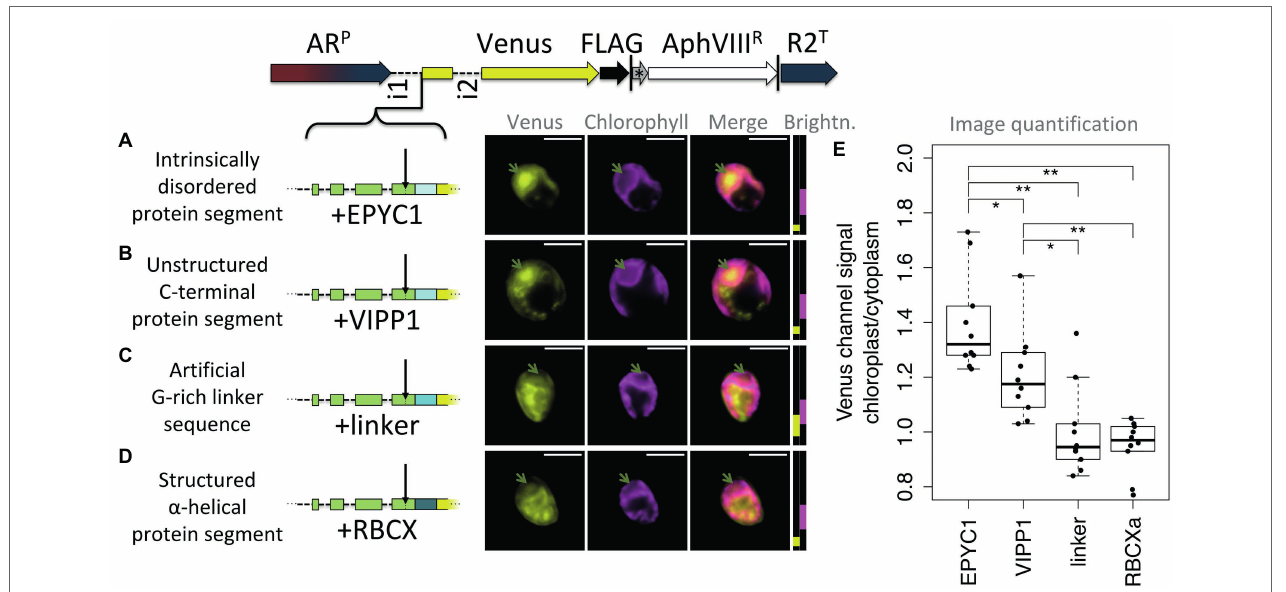
FIGURE 7 | Unstructured downstream sequence aids cTP targeting. The following candidate sequences were inserted downstream of RCA1-cTP + 5 and upstream of Venus: (A) residues 195–213 of intrinsically disordered protein EPYC1, which are part of the 3rd out of 4 repeats; (B) residues 260–278 of VIPP1, which form part of an unstructured C-terminus; (C) an artificial linker sequence mainly consisting of quintuple-G interspersed with S; (D) residues 135–154 of RBCXa, which form part of the most C-terminal α -helix. Refer to Table 1 for amino acid sequences. Green arrows show pyrenoid location; see Figure 1 for further details on representation. (E) Epifluorescence images were quantified by measuring mean Venus channel signal inside and outside the chloroplast. Statistical significance is indicated as: * p < 0.05; ** p < 0.01; Tukey’s honestly significant difference post-hoc test, after